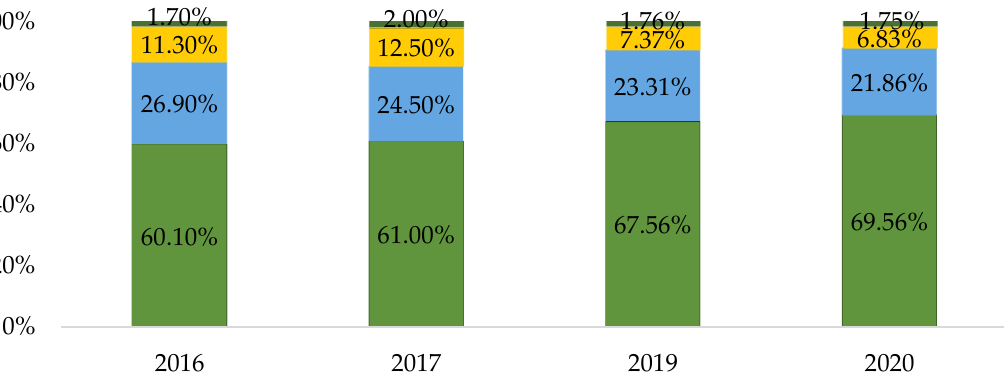
Figure 3. Structure of residential buildings in Poland in 2020 as divided in terms of thermal insulation. Own elaboration based on Central Statistical Office [56].